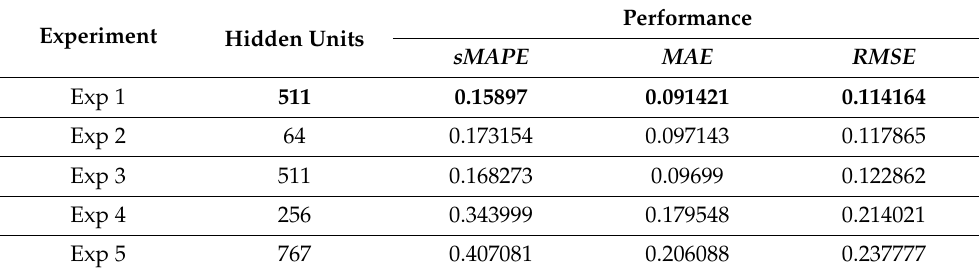
Table 3. LSTM-RNN experiments results.